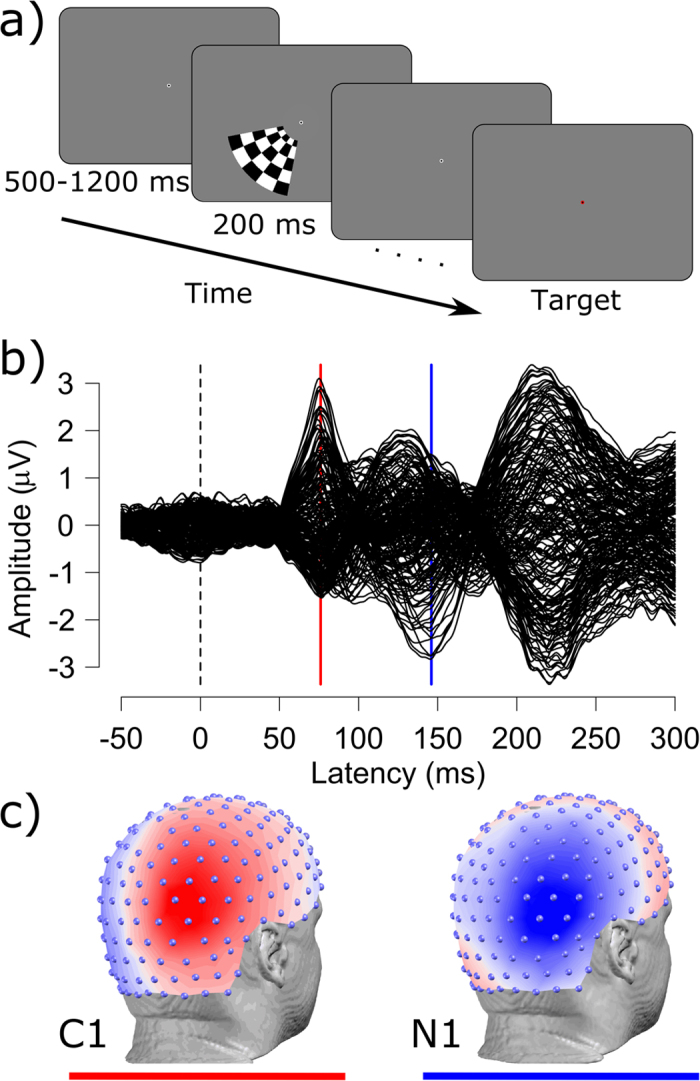
Paradigm and evoked response.(a) illustrates the stimulus presentation sequence. Checkerboards were presented for 200 ms in the lower left or right visual field while the task for participants was to maintain fixation on the center of the screen and respond when the fixation point changed to red (target). (b) shows the grand-average visual evoked response potential across 13 subjects. Each line reflects the average amplitude of one of the 204 electrodes used for analysis. (c) shows the topographic distributions across the scalp of visual evoked potentials at the C1 (76 ms) and N1 (146 ms) peak latency. Grand-average data projected onto the co-registered electrode positions of one participant.